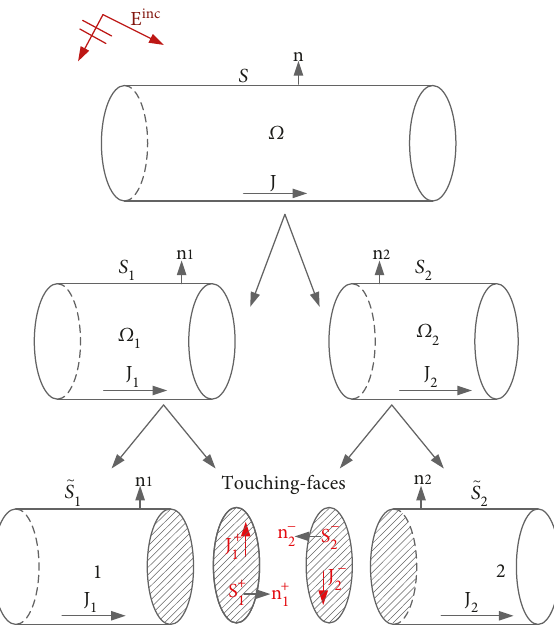
Figure 1: Notations for nonoverlapping